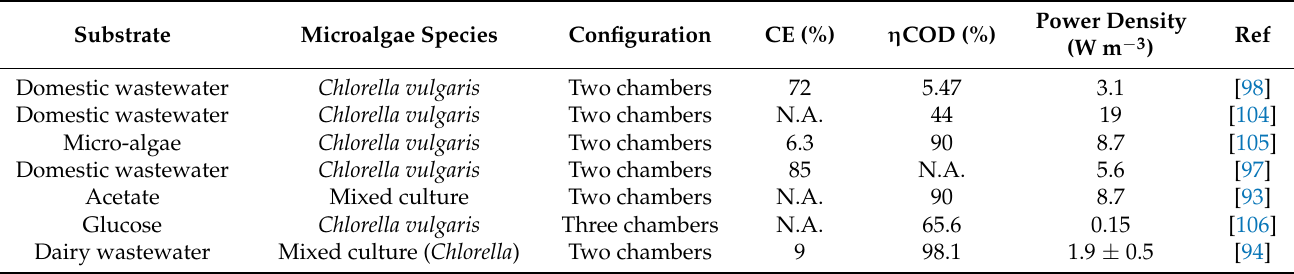
Table 2. Summary of previous experiences in hybrid MFC-microalgae integrated